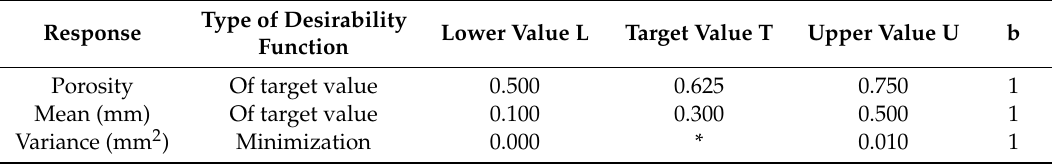
Table 2. Selected values of parameters for